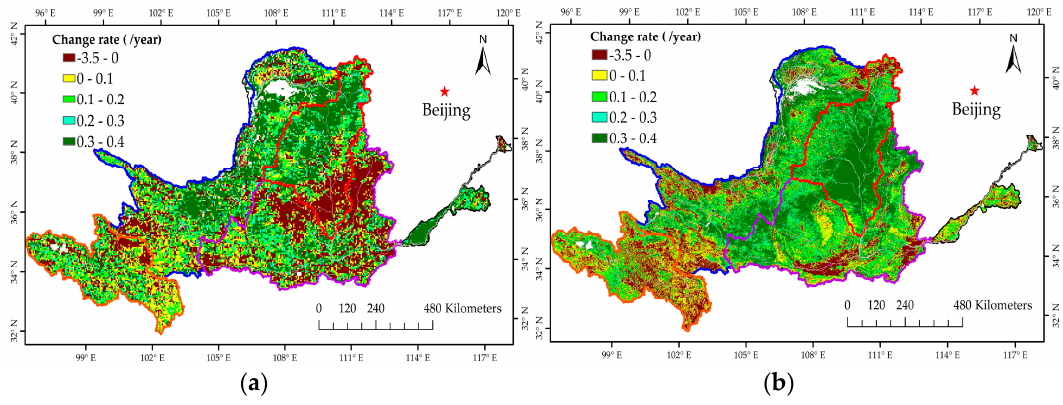
Figure 8. Overall change trend in annual LAI in 1982–2000 ( a ) and in 2001–2013 ( b ) in the YRB.